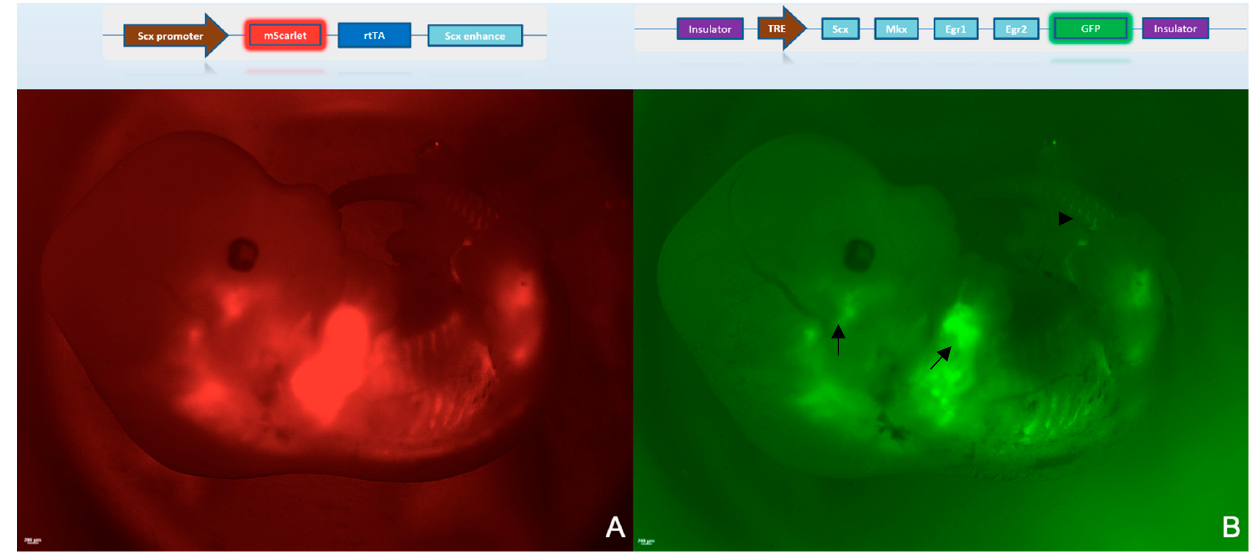
Figure 2. The Td4F-EmGFP expression pattern was consistent with the tendon region reported for Scx-mScarlet. To determine the region of induced expression of the Td4F transgene, we examined the green signal in whole-mount embryos using binocular fluorescence microscopy. The schematic above represents the Scx-rtTA-mScarlet and tetO-Td4F-EmGFP transgenes. ( A ): Scx-rtTA-mScarlet embryos at E12.5 under binocular fluorescence microscopy (×10 magnification). ( B ): tetO-Td4F-EmGFP embryo at E12.5 under binocular fluorescence microscopy (×10 magnification) (arrows show tendons around the developing maxillofacial and forelimbs; arrowheads show mScarlet expression in the tail).